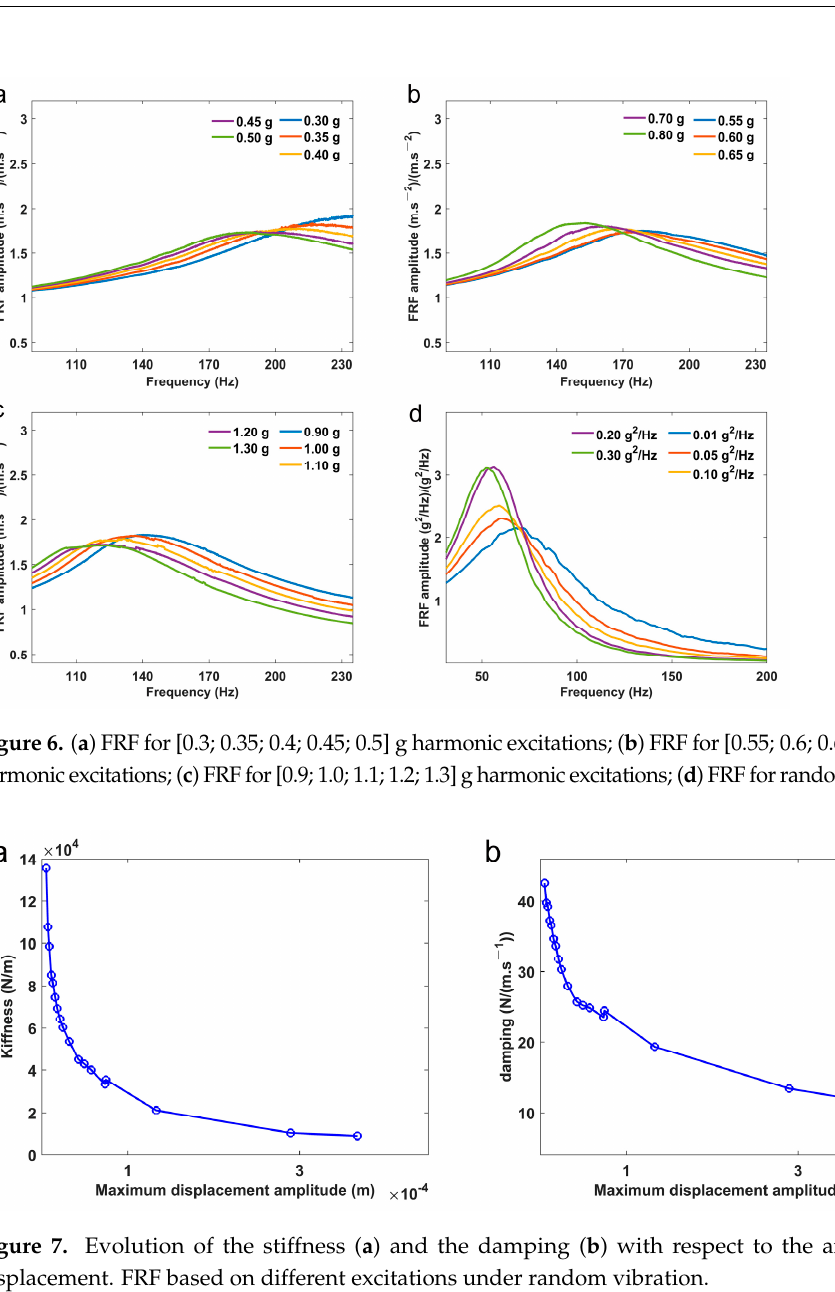
Figure 7. Evolution of the stiffness ( a ) and the damping ( b ) with respect to the amplitude of displacement. FRF based on different excitations under random vibration.